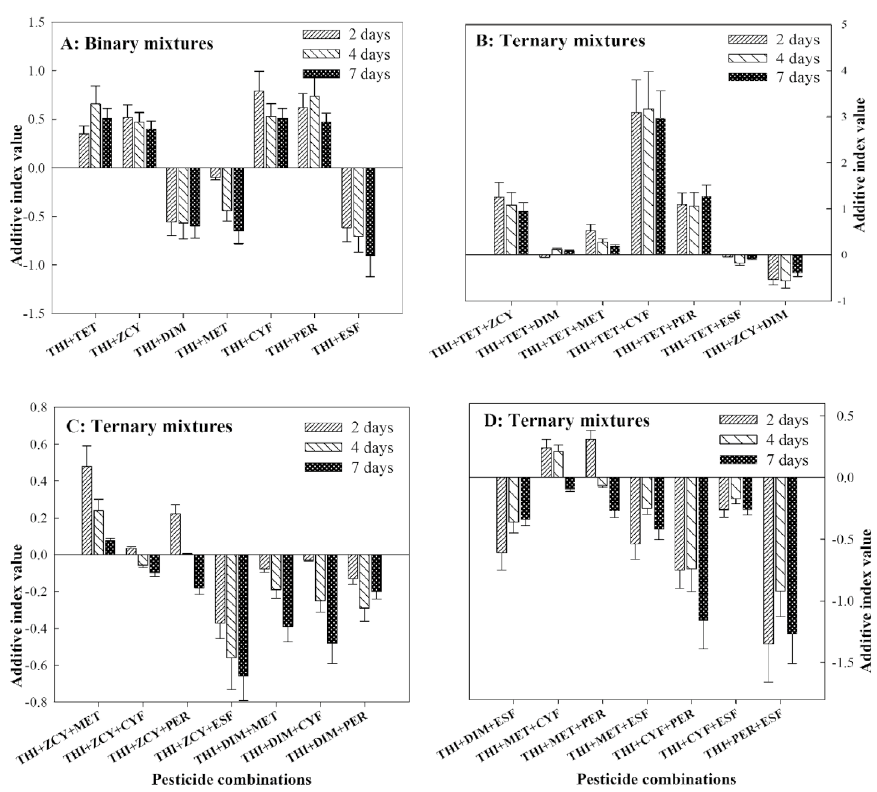
Figure 1. Joint toxic effects of binary and ternary combinations of thiamethoxam (THI) mixed with seven pesticides on honey bees. CI confidence interval, THI Thiamethoxam, TET Tetraconazole, ZCY Zeta - cypermethrin, DIM Dimethoate, MET Methomyl, CYF Cyfluthrin, PER Permethrin, ESF